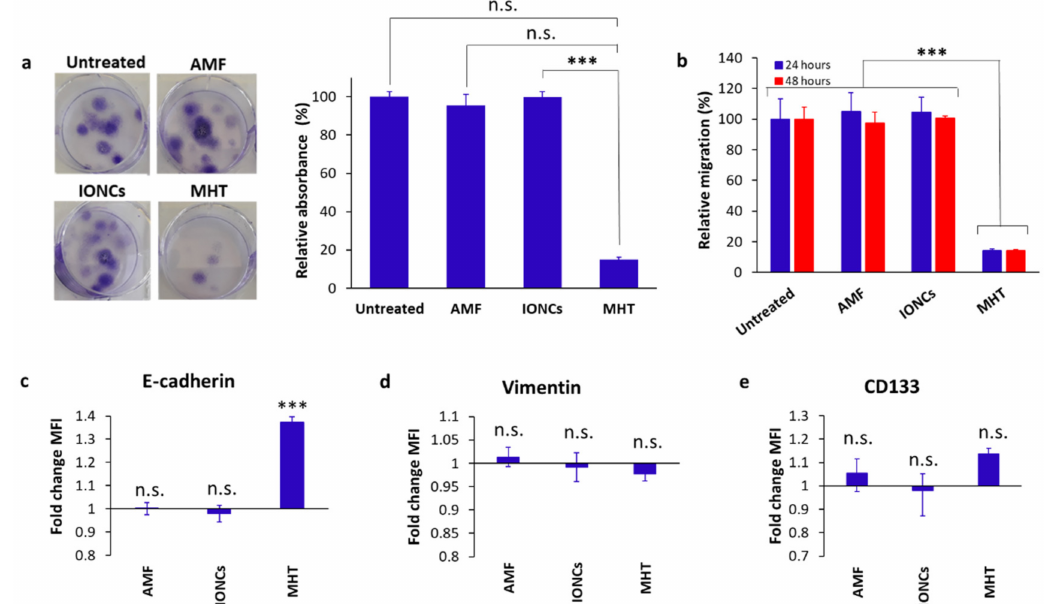
Figure 3. Evaluation of the clonogenic ( a ) and migration ( b ) activity, surface expression of EMT ( c , d ) and CSC markers ( e ) in U87 cells in response to treatment with IONCs and mild MHT (3 cycles of 30 min at 43 ◦ C). Clonogenicity was evaluated in U87 cells after treatment with AMF, IONCs and MHT ( a ). Data are shown as representative images of stained colony with crystal violet and relative absorbance at 595 nm. A transwell assay was used to determine the migration and invasion ability of U87 cells after exposition to different treatments such as AMF only (AMF), IONCs only (IONCs) and IONCs + AMF (MHT) ( b ). The results are represented as relative percentage compared to untreated cells ( d ). Error bars indicate ± SD calculated from three independent experiments ( n = 3). Surface expression of E-cadherin, Vimentin and CD133 was measured via flow cytometry at 24 h post-treatment with AMF, IONCs and MHT, and data reported relative to untreated controls ( c – e ). Data are represented as mean ± SD of three independent experiments ( n = 3). Statistical analysis was conducted with a two − tail unpaired student’s t test (*** p < 0.001; n.s. = not